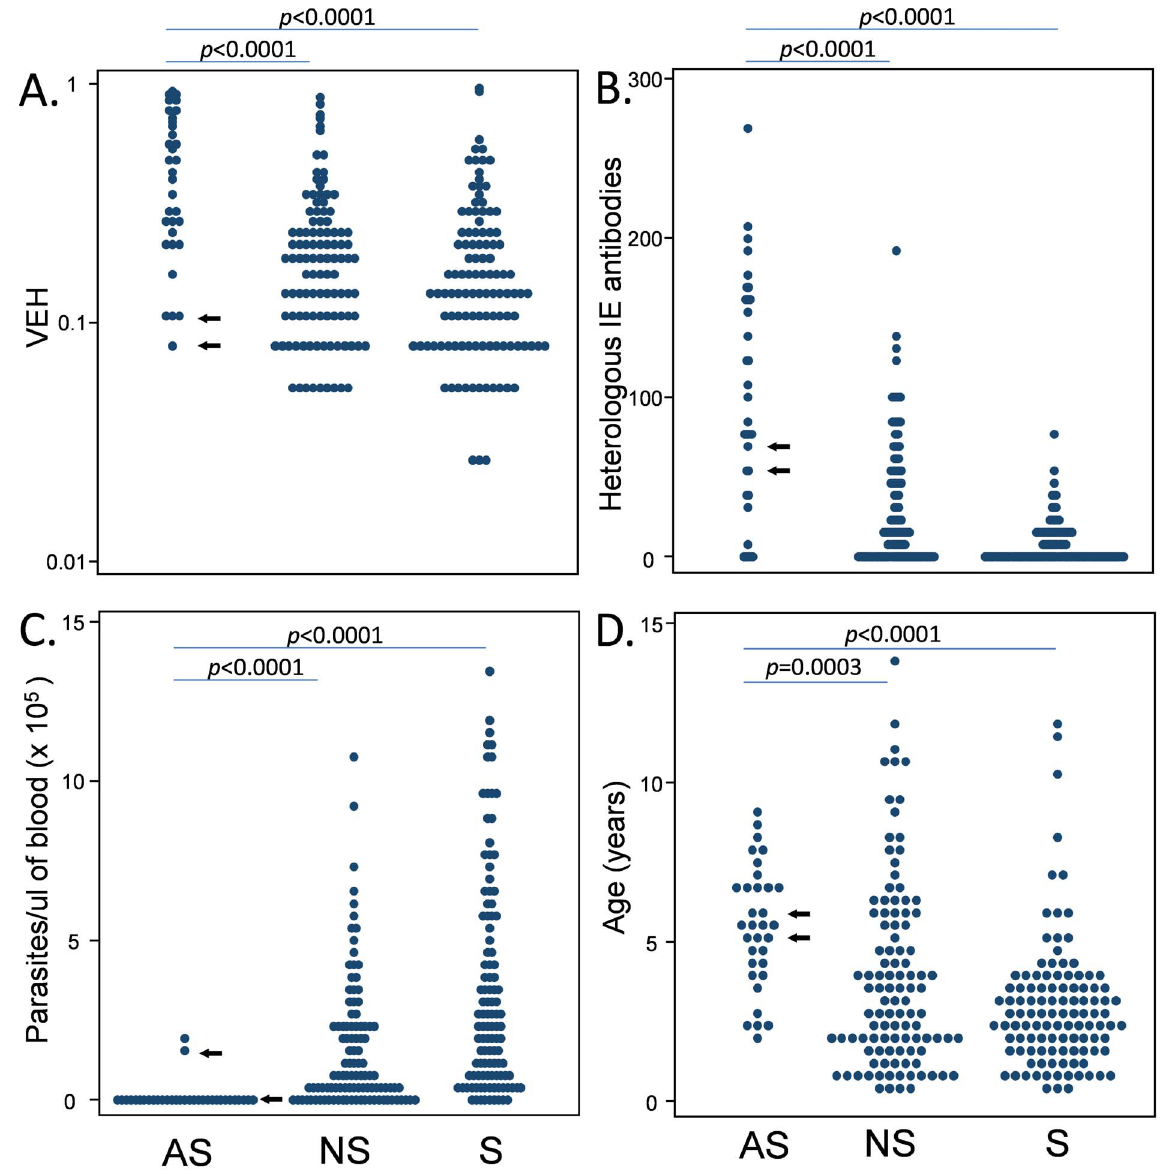
Figure 2. Comparisons of VEH, IE surface antibody breadth, parasitaemia and host age. The Mann-Whitney U test is used to compare asymptomatic and clinical infections in relation to VEH (A); heterologous IE surface antibody breadth measured as the median of the mean fluorescence intensities measured against eight different parasite isolates as described previously [21] (B); parasitaemia (parasites 6 10 5 / m l blood, C); host age (D). Blue arrows are used to indicate two individuals (46C and 46D) who became symptomatic with within the two days of sampling.